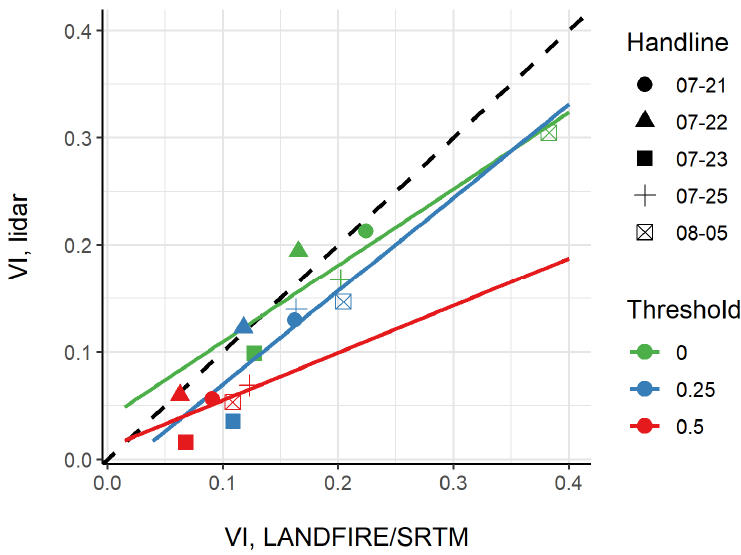
Figure 7. VI across resolutions. Connected points represent VI derived from lidar-based viewsheds for each handline. ( a ) VI, no threshold. ( b ) VI 0.25 , x = 25% threshold applied. ( c ) VI 0.5 , x = 50% threshold applied.